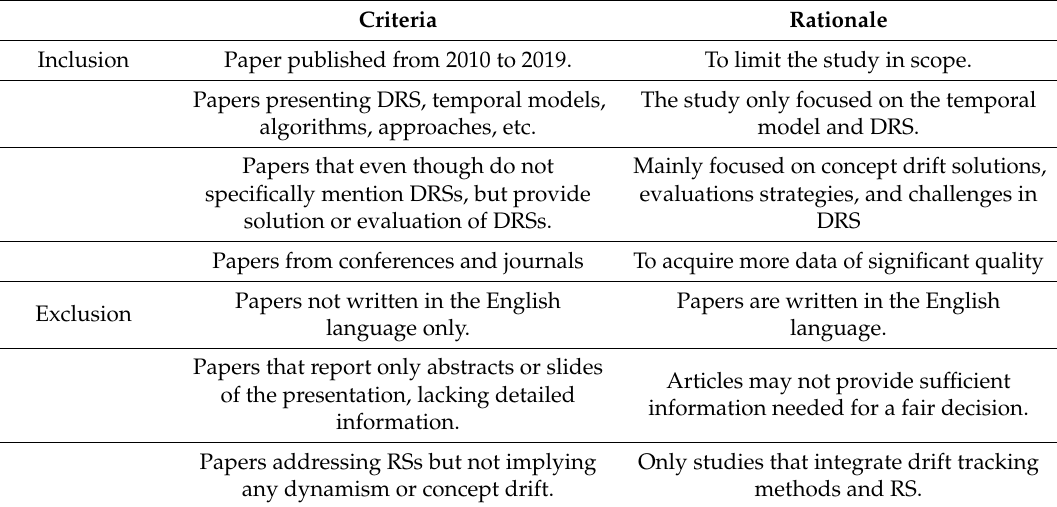
Table 1. Inclusion and Exclusion